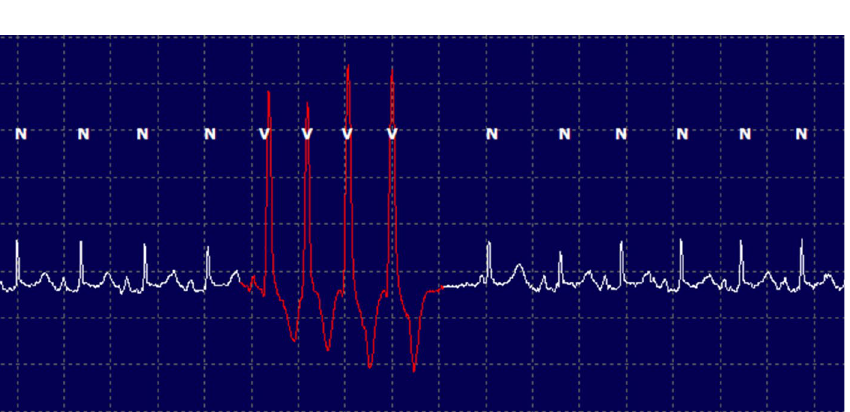
Figure 2. Example of ventricular tachycardia (complexity level 4) obtained via AECG in one cat from the HCM